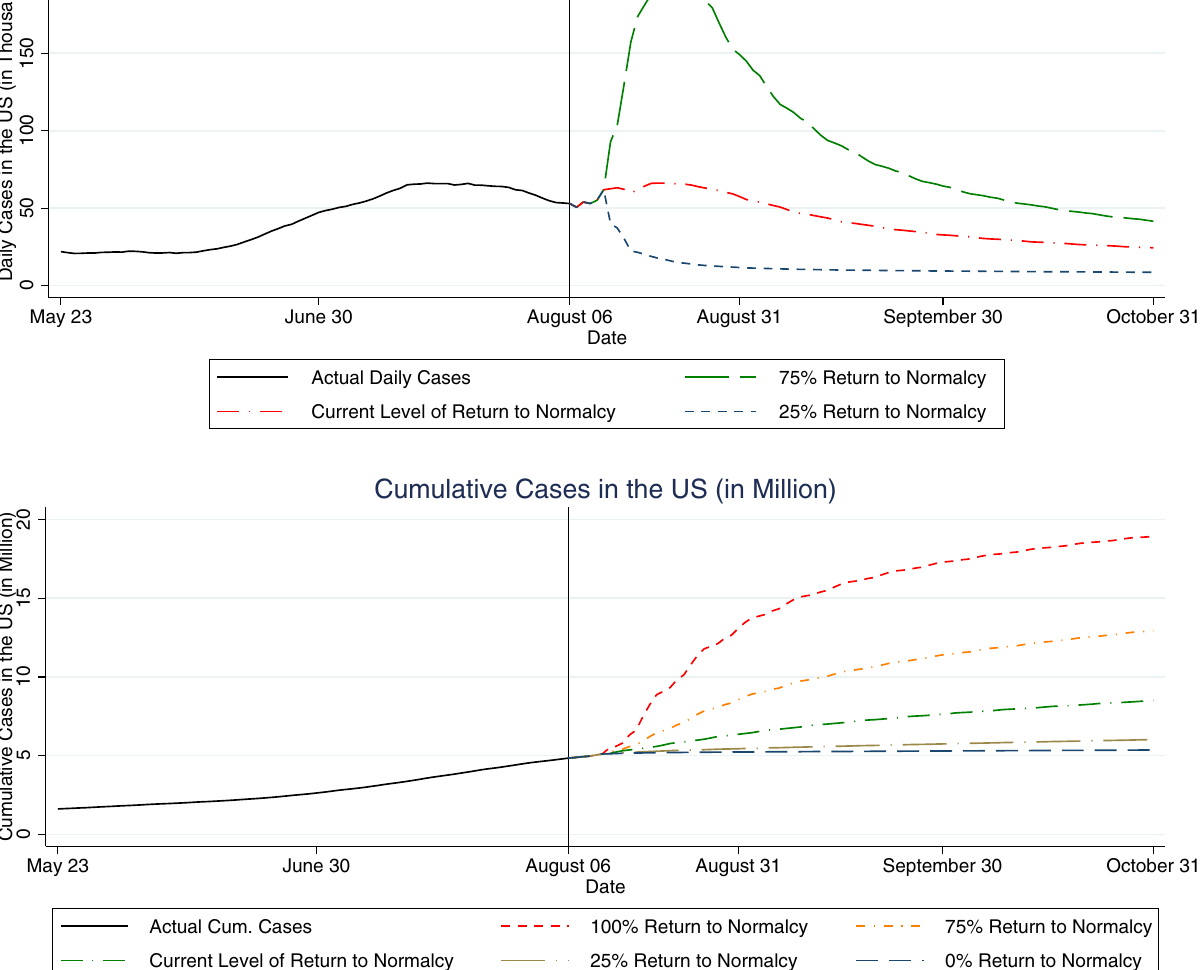
Figure 3. Daily and cumulative cases forecasting under different reopening strategies. The vertical line indicates the last date of case data